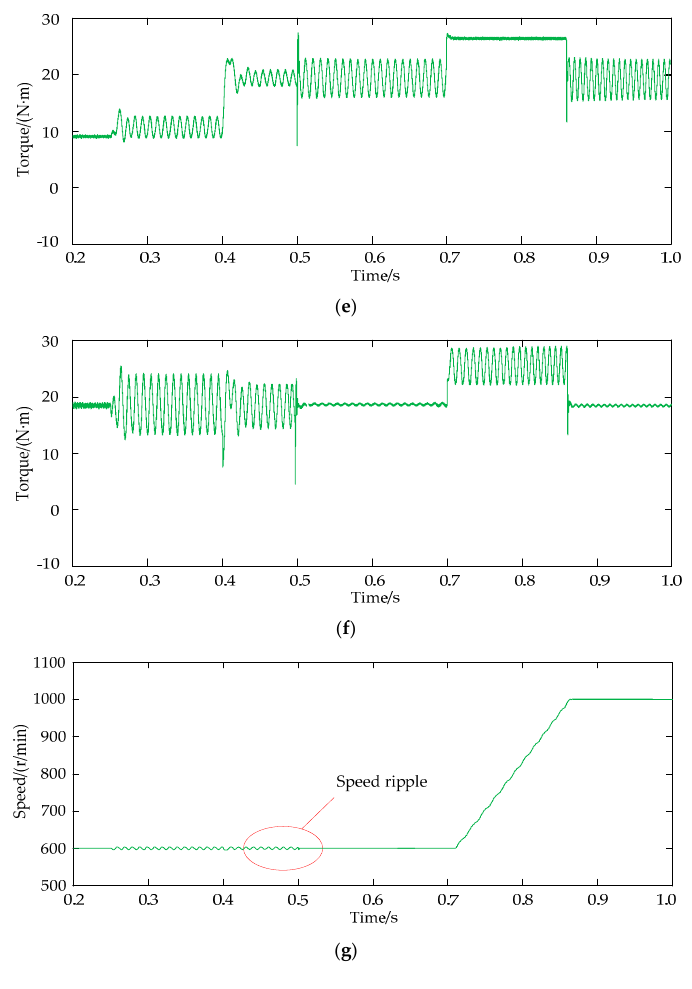
Figure 14. The waveform of simulation: ( a ) The current waveform of contact resistance; ( b ) The three-phase current waveform of fault windings; ( c ) The three-phase current waveform of normal windings; ( d ) The electromagnetic torque of fault windings; ( e ) The electromagnetic torque of normal windings; ( f ) The output electromagnetic torque; ( g ) The waveform of speed. Table 3. Parameters of DRPMSM.